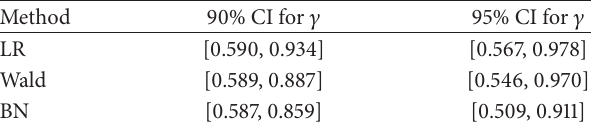
Table 3: Results for 90% and 95% confidence intervals for 𝛾